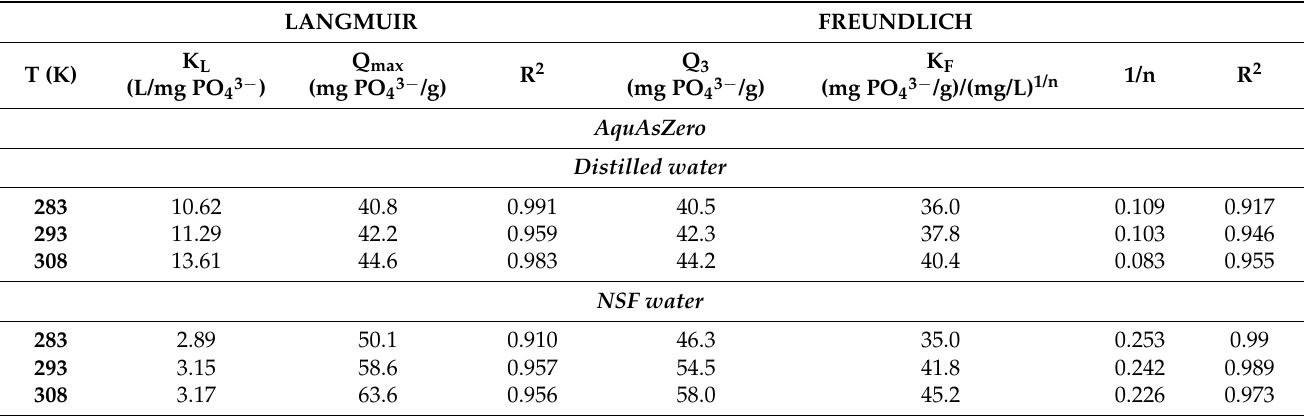
Table 2. Fitting parameters regarding the adsorption of phosphates at pH